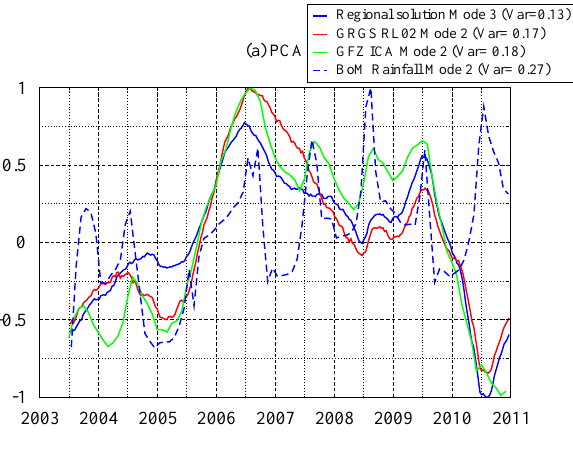
Fig. 10. Spatial components of PCA 2nd orthogonal mode of re- gional solutions and 3rd mode of GRGS, ICA 400km-filtered solu- tions and rainfall product.